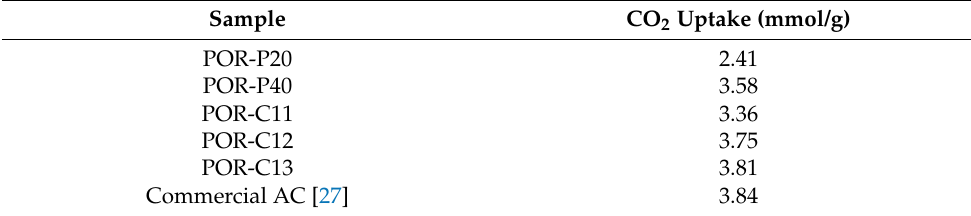
Table 4. CO 2 uptake results of the physical and chemical activated samples tested at 25 ◦